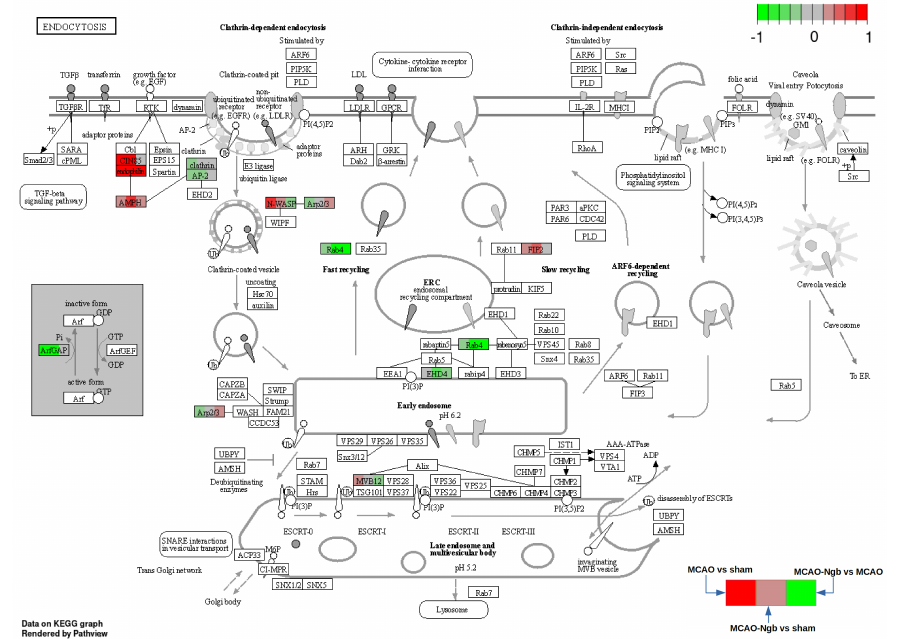
Figure 13. KEGG pathway hsa04144: endocytosis. Arrows and symbols explanation: